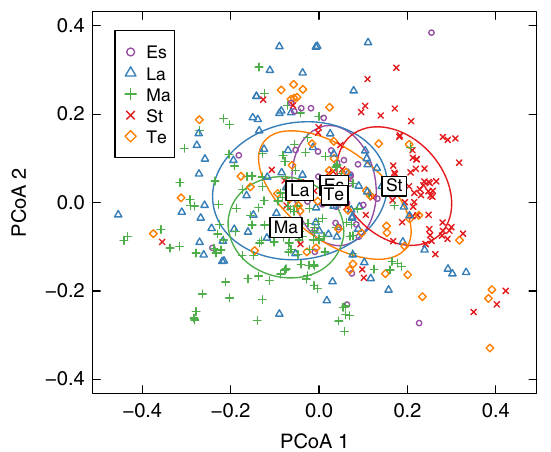
Fig. 2 Principal coordinate analysis of the dissimilarity matrix ^ E containing the normalized pairwise distances between all food webs. Each different color represents the group of networks from estuaries (Es), lakes (La), marine (Ma), streams (St), and terrestrial (Te) ecosystems. The ellipses characterize the 1 standard deviation ellipses about the group medians